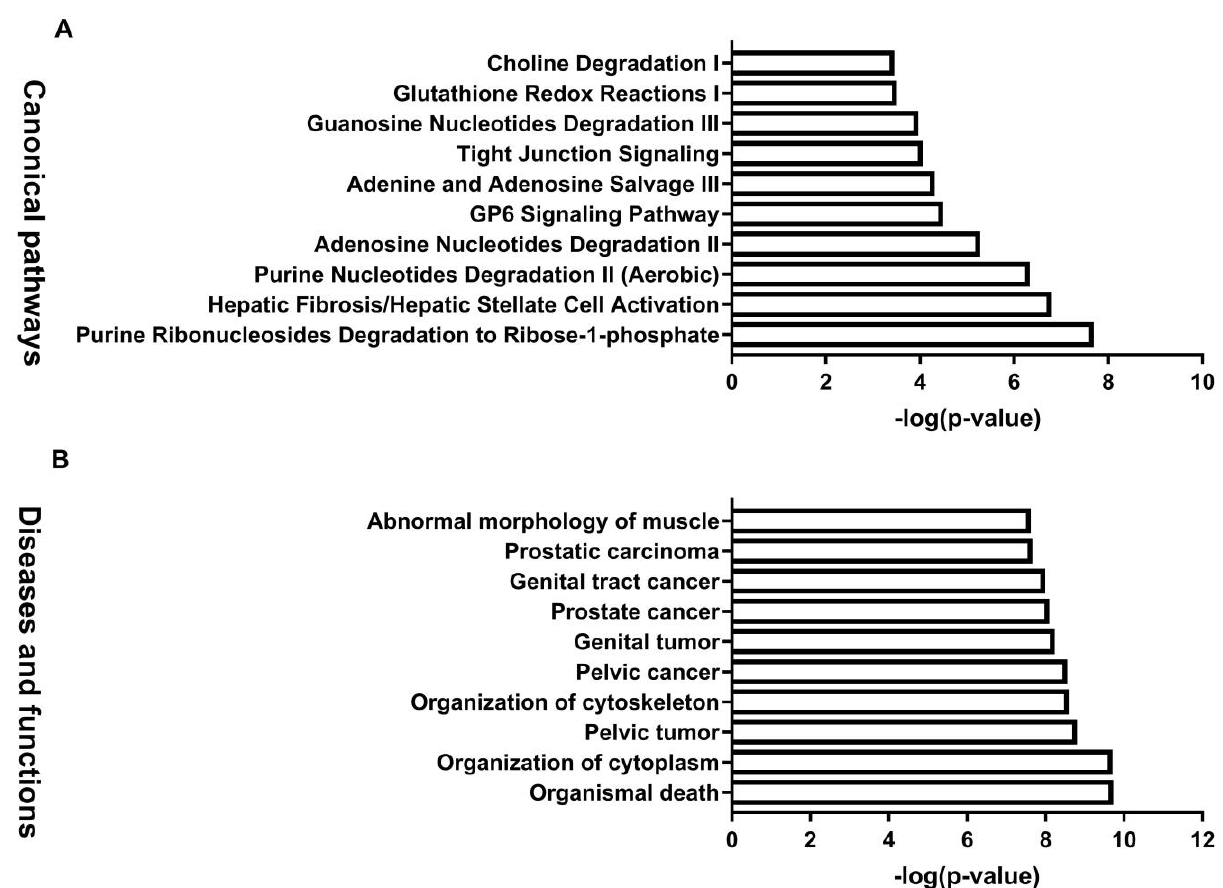
Figure 4. Canonical pathway, and diseases and functions analysis of the differentially expressed proteins. ( A ): Canonical pathway enrichment analysis for sets of the differentially expressed genes. ( B ): Diseases and functions enrichment analysis. A p value < 0.05 and an FDR value < 0.05 were selected as the significant criteria.